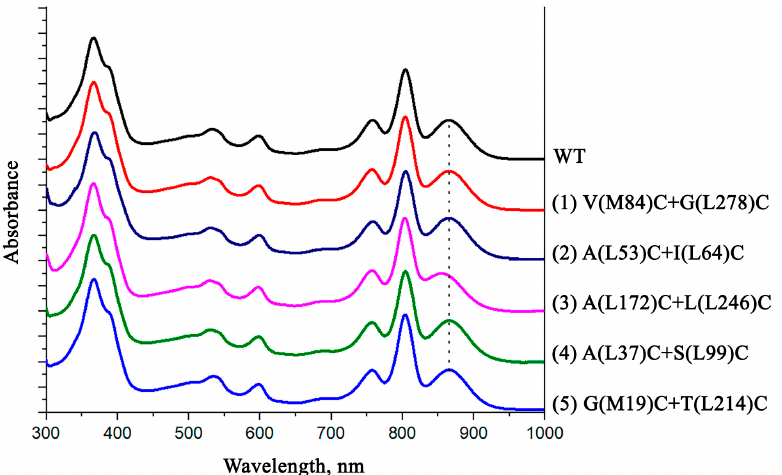
Figure 4. Electronic ground-state absorption spectra of the wild-type C. sphaeroides reaction center and its mutant forms. Spectra were measured at room temperature and normalized at the Q Y H absorption band.